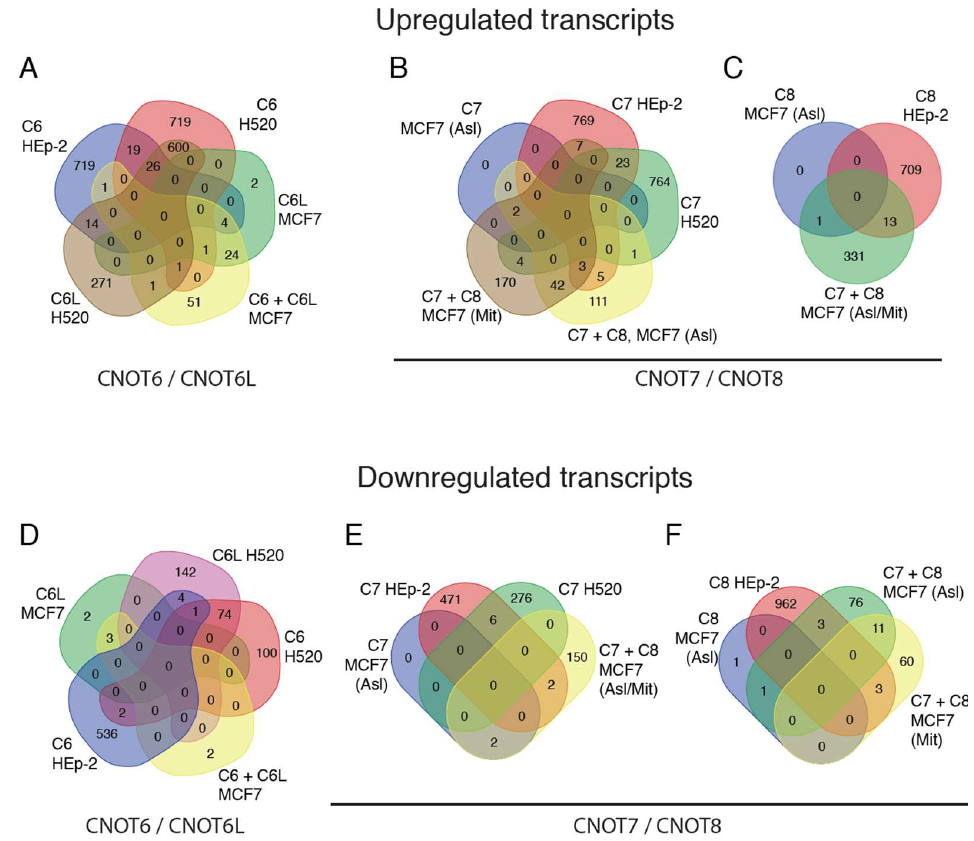
Figure 3. Upregulated and downregulated transcripts upon deadenylase silencing in NCI-H520, HEp-2, and MCF7 cells. ( A – C ) Venn diagrams showing upregulated transcripts after silencing of CNOT6 and CNOT6L, CNOT7 and CNOT8 in NCI-H520, HEp-2, and MCF7 cells. ( A ) Silencing of CNOT6 and CNOT6L in NCI-H520, HEp-2, and MCF7 cells, and in combination with CNOT6L (C6 + C6L) in MCF7 cells. ( B ) Silencing of CNOT7 in NCI-H520, HEp-2, and MCF7 cells and in combination with CNOT8 (C7 + C8) in MCF7 cells. ( C ) Silencing of CNOT8 in HEp-2 and MCF7 cells, and in combination with CNOT7 (C7 + C8) in MCF7 cells. ( D – F ). Venn diagrams showing downregulated transcripts after silencing of CNOT6, CNOT6L, CNOT7, and CNOT8 in NCI-H520, HEp-2, and MCF7 cells. ( D ) Silencing of CNOT6 and CNOT6L in NCI-H520, HEp-2, and MCF7 cells, and in combination (C6 + C6L) in MCF7 cells. ( E ) Silencing of CNOT7 in NCI-H520, HEp-2, and MCF7 cells, and in combination with CNOT8 (C7 + C8) in MCF7 cells. ( F ) Silencing of CNOT8 in HEp-2 and MCF7 cells, and in combination with CNOT7 (C7 + C8) in MCF7 cells. The numbers represent differentially expressed transcripts, the levels of which are altered by FC ≥ 1.5 upon silencing of the indicated deadenylase. The data for transcripts from MCF7 cells are from the studies of Aslam et al. and Mittal et al. [52,53]. Asl, Aslam; Mit, Mittal; Asl/Mit, Aslam/Mittal, respectively. C6, CNOT6; C6L, CNOT6L; C7, CNOT7; C8,